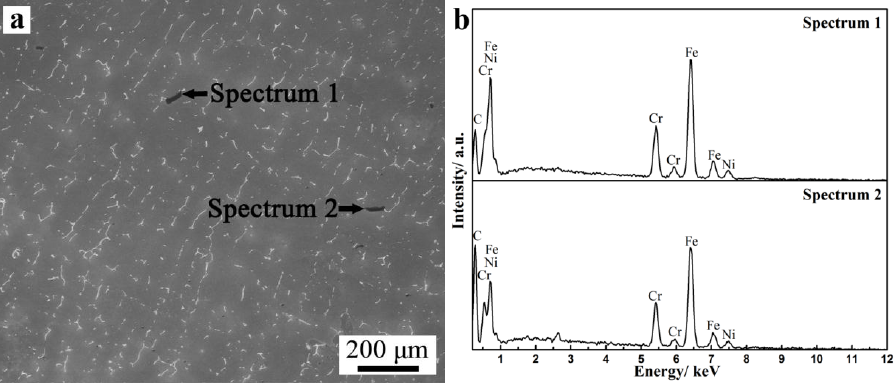
Figure 9. ( a ) SEM micrograph and ( b ) energy dispersive spectrometer (EDS) images of precipitates